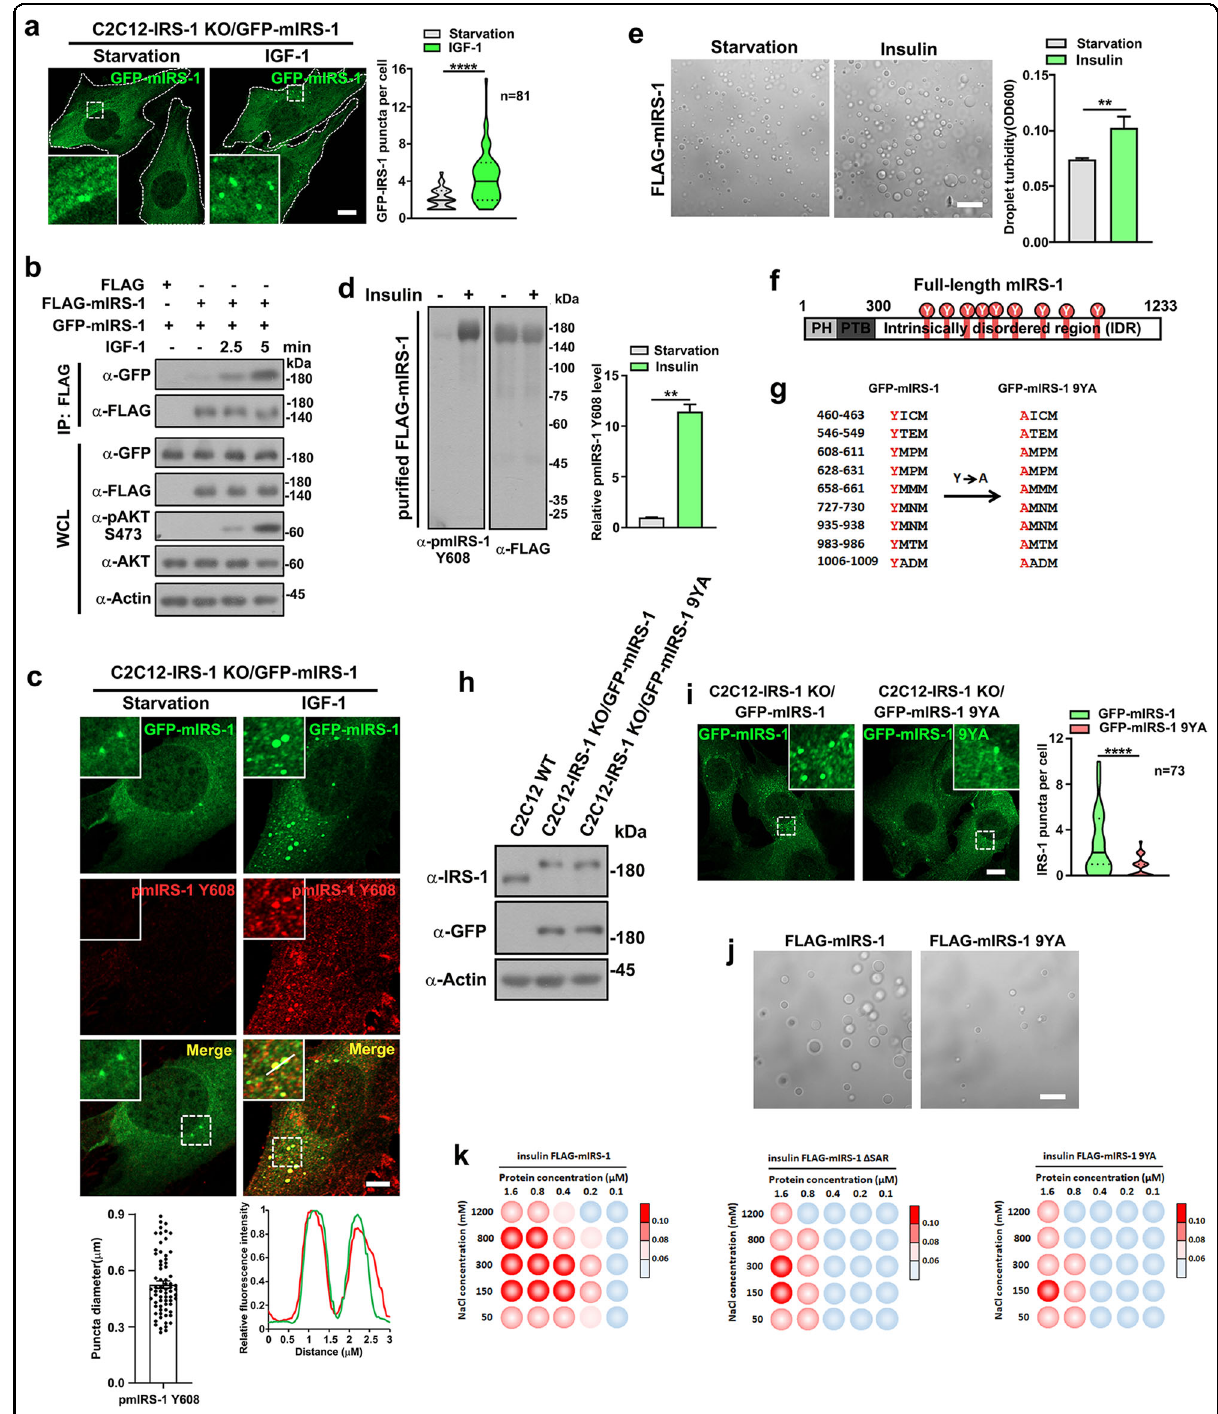
Fig. 4 (See legend on next